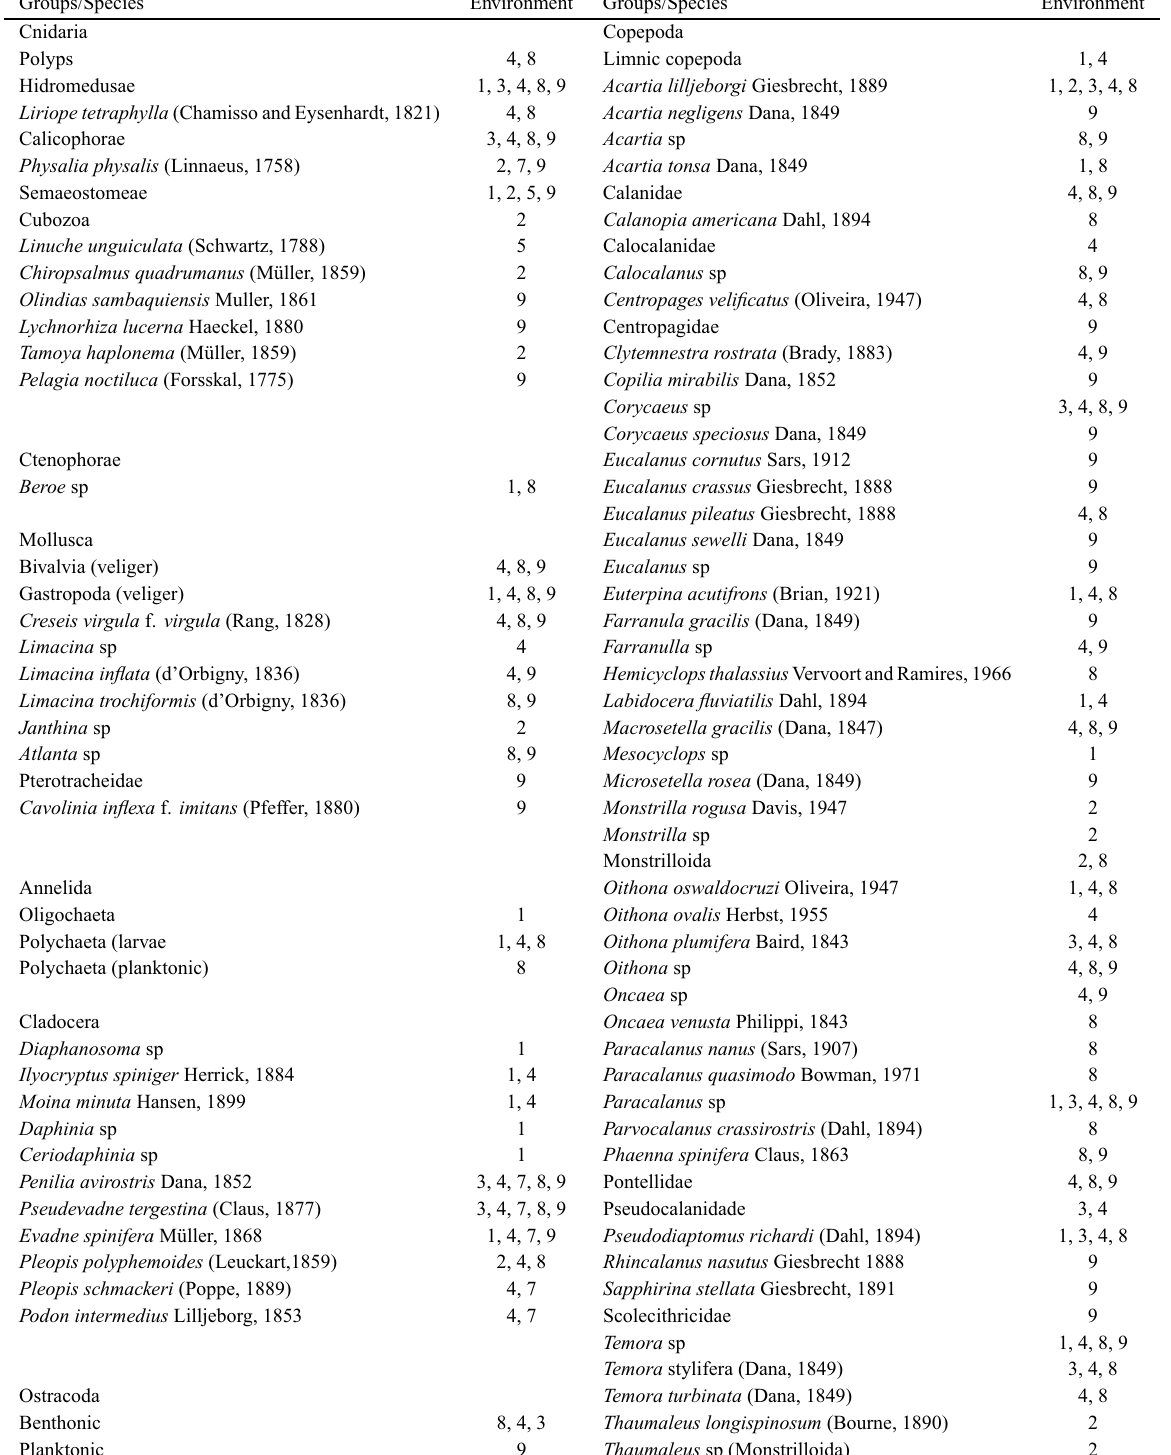
Taxa of zooplankton identified in different areas (according to the caption of Fig. 1) of the Santa Catarina coast.